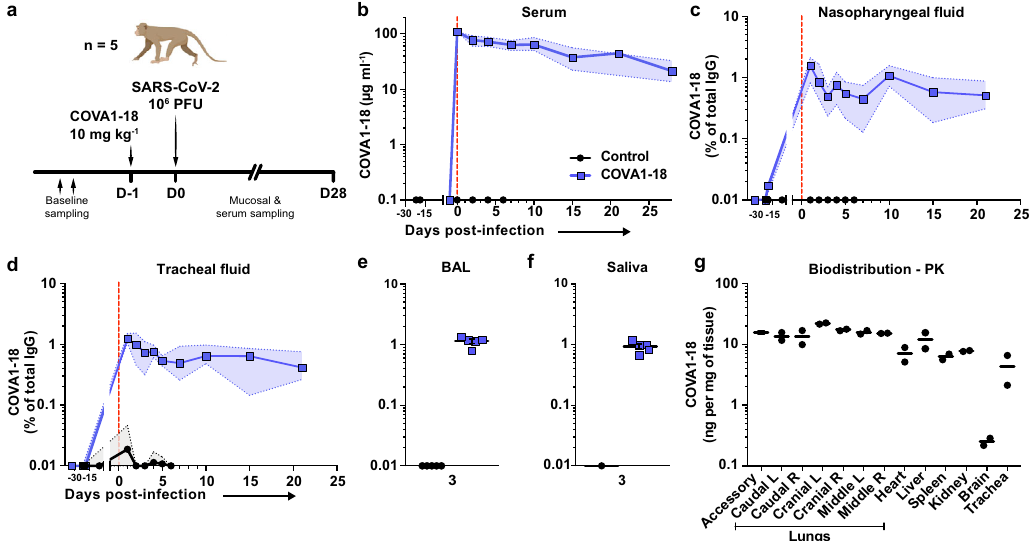
Fig. 2 COVA1-18 serum and mucosal pharmacokinetic in infected cynomolgus macaques. a Study design. Two groups of n = 5 were exposed to 10 6 PFU of SARS-CoV-2 (intranasal and intratracheal routes). Treated animals received 10 mg kg − 1 of COVA1-18 1 day before challenge. b COVA1-18 serum concentration (mean with range). COVA1-18 concentration reported as percent of total cynomolgus IgG in heat-inactivated ( c ) nasopharyngeal fl uid, d tracheal fl uid (means with range), e bronchoalveolar lavage (BAL) and f saliva (means ± SEMs) with n = 5, except for the control group in ( f ) where n = 1. g The two macaques from the pharmacokinetic study were euthanized at 24 h post-treatment and their organs analyzed to assess the biodistribution of COVA1-18. The concentration of COVA1-18 was normalized to the weight of each sample for every organ. Bars represent means. The red dashed line indicates challenge day. L left, PFU Plaque forming unit, PK pharmacokinetic, R right.